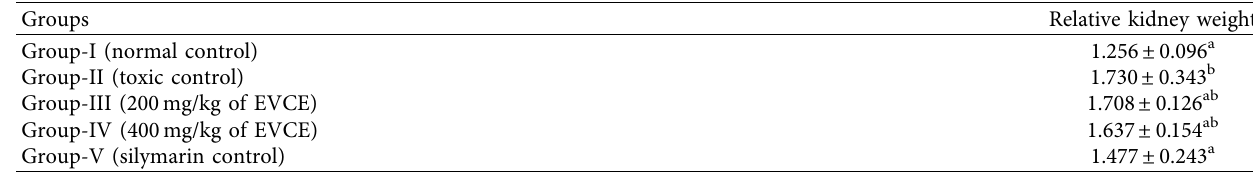
Table 4: Relative kidney weight in different experimental groups of